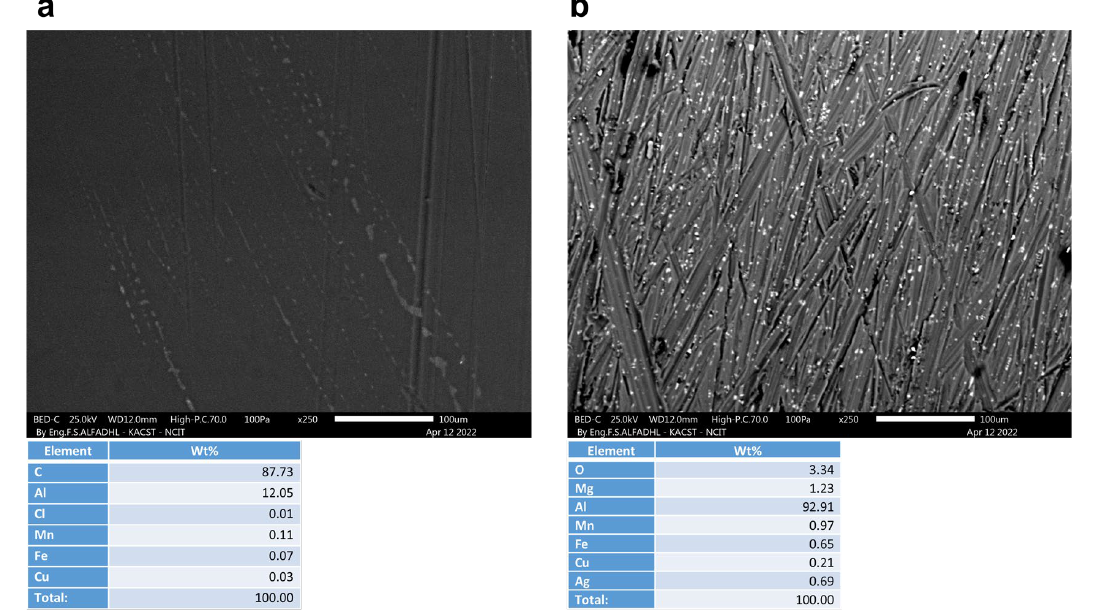
Figure 9. SEM and EDS analysis of untested, blank Red Bull samples ( a ) with an organic coating (WC) and ( b ) without an organic coating (WOC).